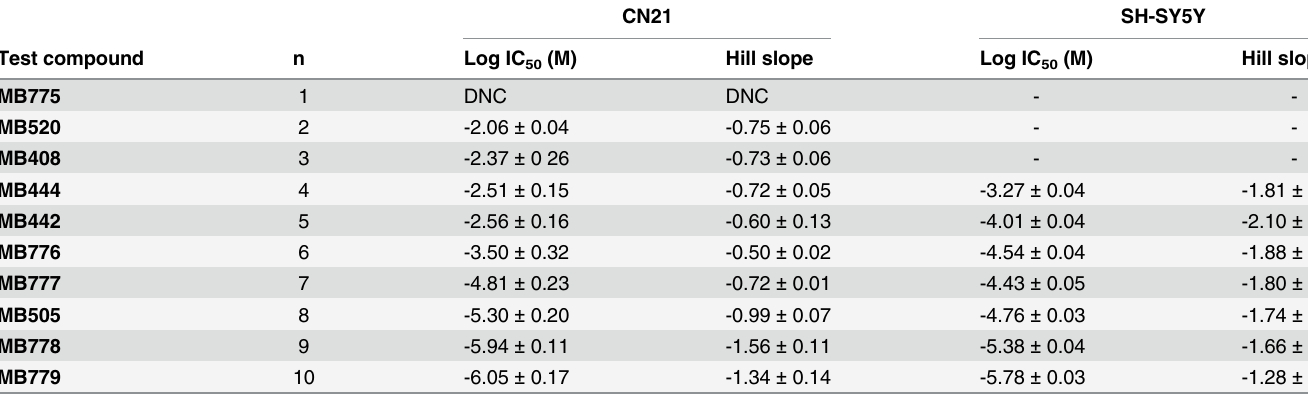
Table 1. Inhibition of nicotinic responses in CN21 and SH-SY5Y cells.